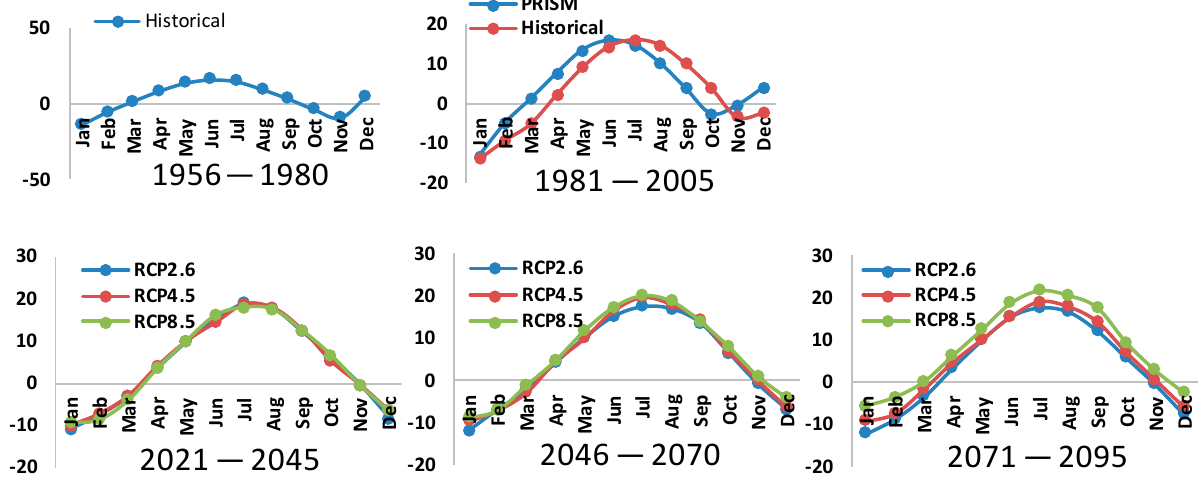
Figure 1. Trends in monthly average minimum temperature ( ◦ C) patterns for each climate scenario. Agriculture 2023 , 13 , 268 Average monthly maximum temperature patterns: Average monthly maximum tem ‐ peratures were computed in a similar manner (Figure 2). They represent the maximum monthly temperatures averaged over the 25 ‐ year time horizon for reach climate scenario, and then an area ‐ weighted average taken across all simulated grid points. RCP8.5 projec ‐ tions once again yield the highest monthly values. Monthly maximum temperatures are highest with the RCP8.5 projection, particularly for June through September, and January and February, which are markedly higher than the other two RCP projections. Average monthly precipitation patterns: Annual precipitation levels indicate higher overall levels for RCP8.5 as compared to current patterns and other climate projections. However, of more relevance to corn yields are precipitation levels in the growing season. Average monthly precipitation patterns are shown in Figure 3, and were computed as monthly total precipitation levels, averaged over the 25 ‐ year time period for each climate scenario, and then an area ‐ weighted average taken across all applicable grid points asso ‐ ciated with the crop–soil polygons. The charts indicate that the bulk of the annual precip ‐ itation increase associated with RCP8.5 for the 2021–2045 period is projected to occur in the August through November months.